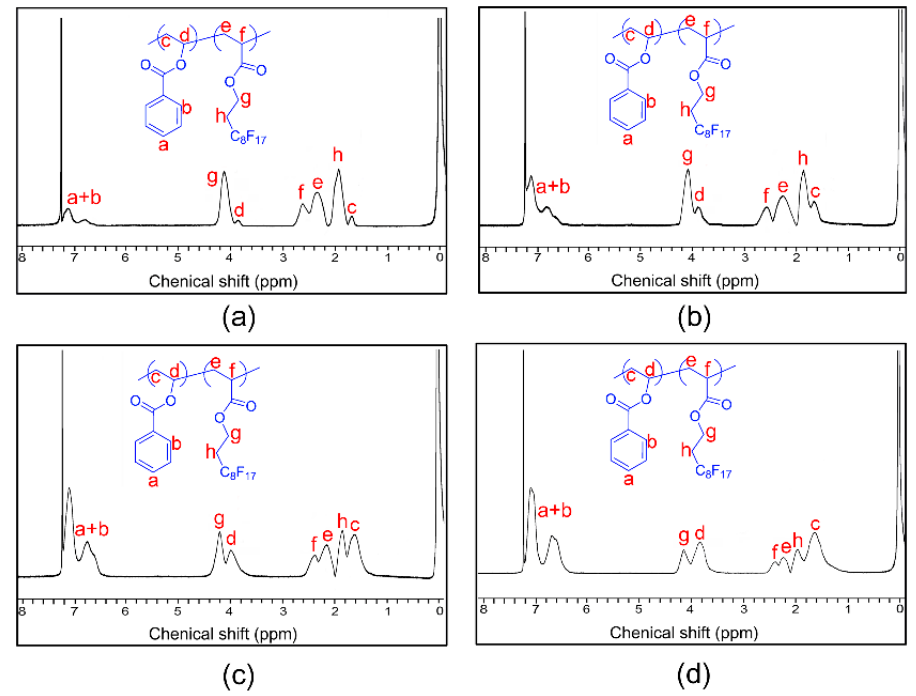
Figure 3. 1 H-NMR spectrums for P(HFDA- co -VBe) co-polymers. ( a ) P(HFDA 0.87 - co -VBe 0.13 ); ( b ) P(HFDA 0.67 - co -VBe 0.33 ); ( c ) P(HFDA 0.50 - co -VBe 0.50 ); ( d ) P(HFDA 0.29 - co -VBe 0.71 ).